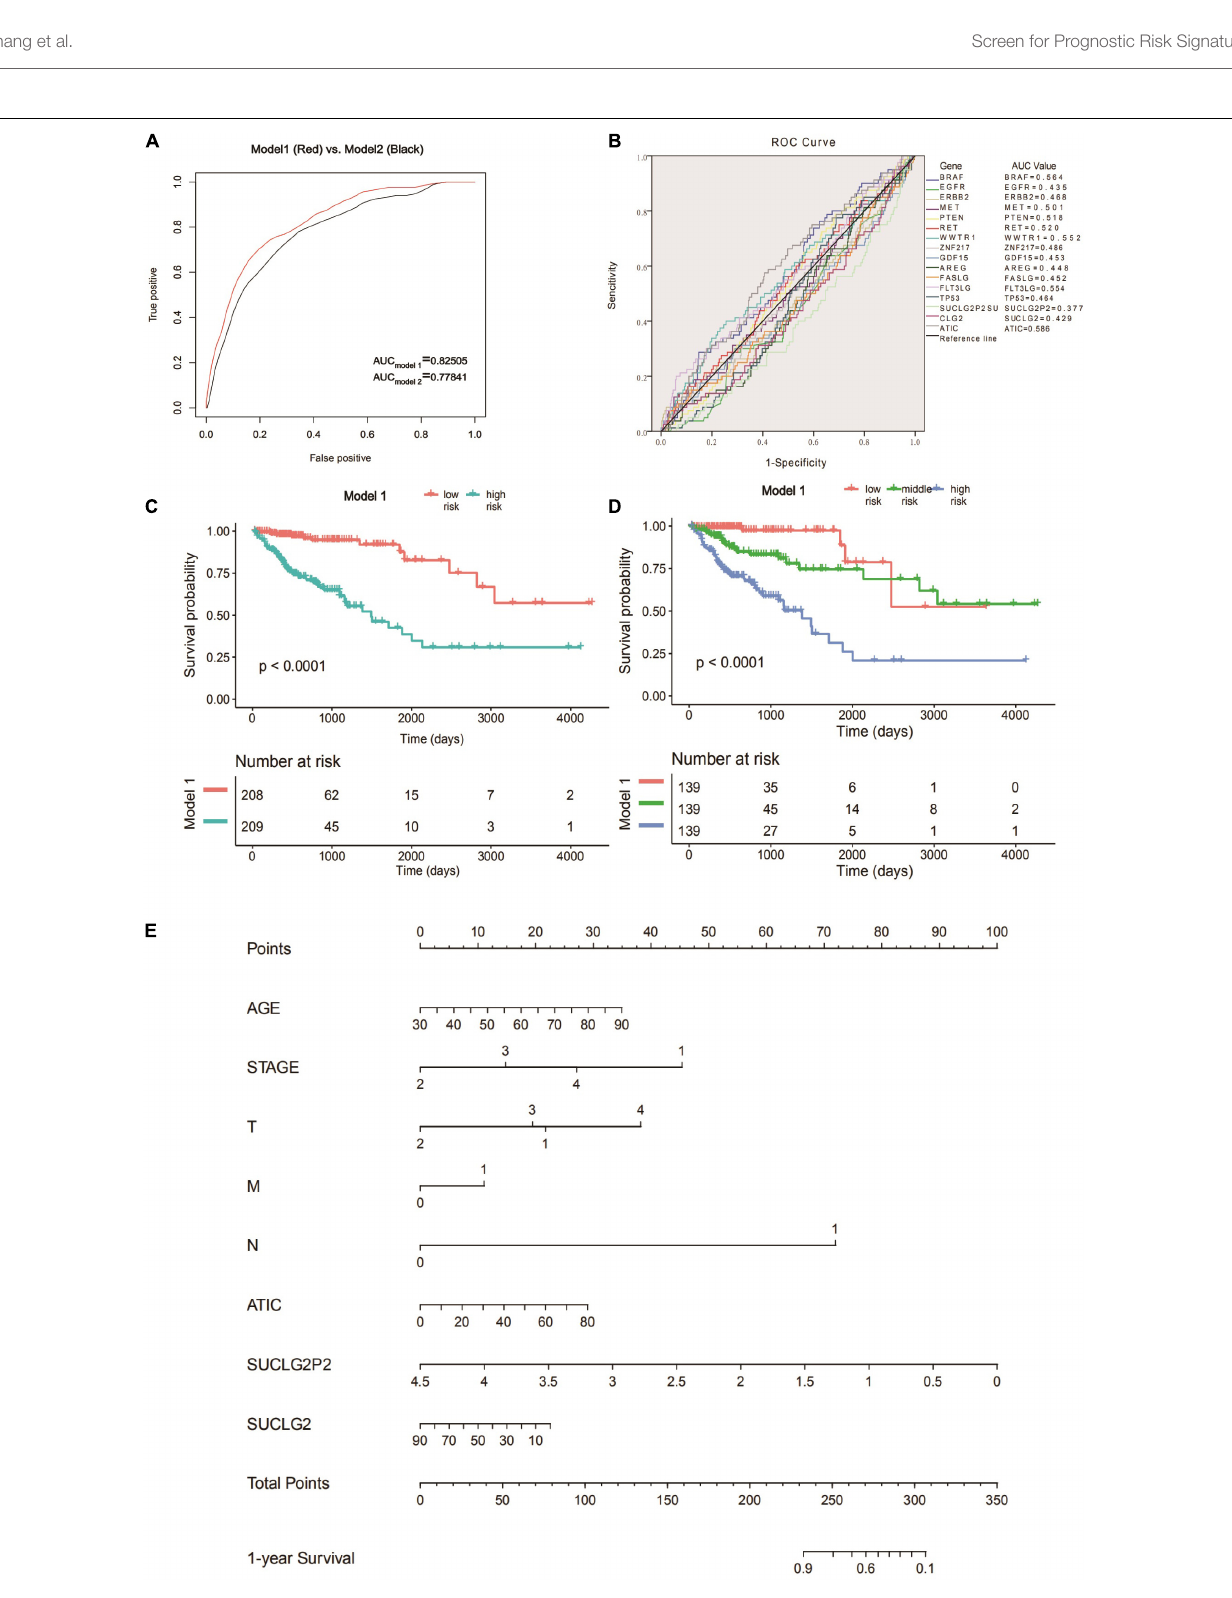
Frontiers in Genetics |